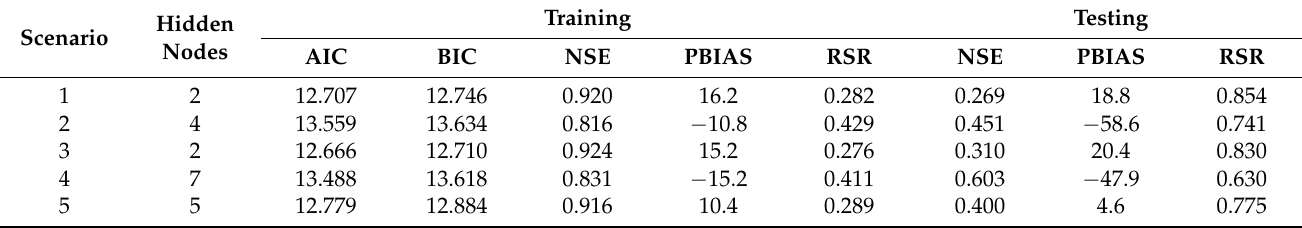
Table 5. AIC selected models with the optimum number of hidden nodes,